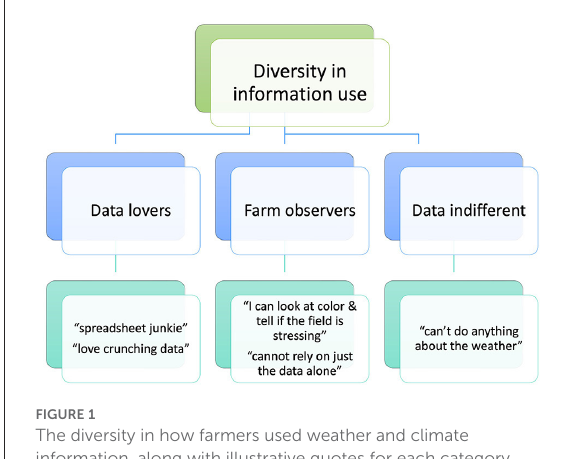
FIGURE1 The diversity in how farmers used weather and climate information, along with illustrative quotes for each category. “Data lovers” based many decisions on detailed analysis of multiple data sets, wet ions. “Farm observers” often used data but preferred to make decisions based on their observations or visual monitoring of crop health and performance. They used data/information as an add-on to the visual signals they could observe. Finally, there were some farmers who were “data indifferent”, who said that they monitor the weather for some critical parameters like extreme heat or frost but did not pay too much attention to data since there was not much one can do about the